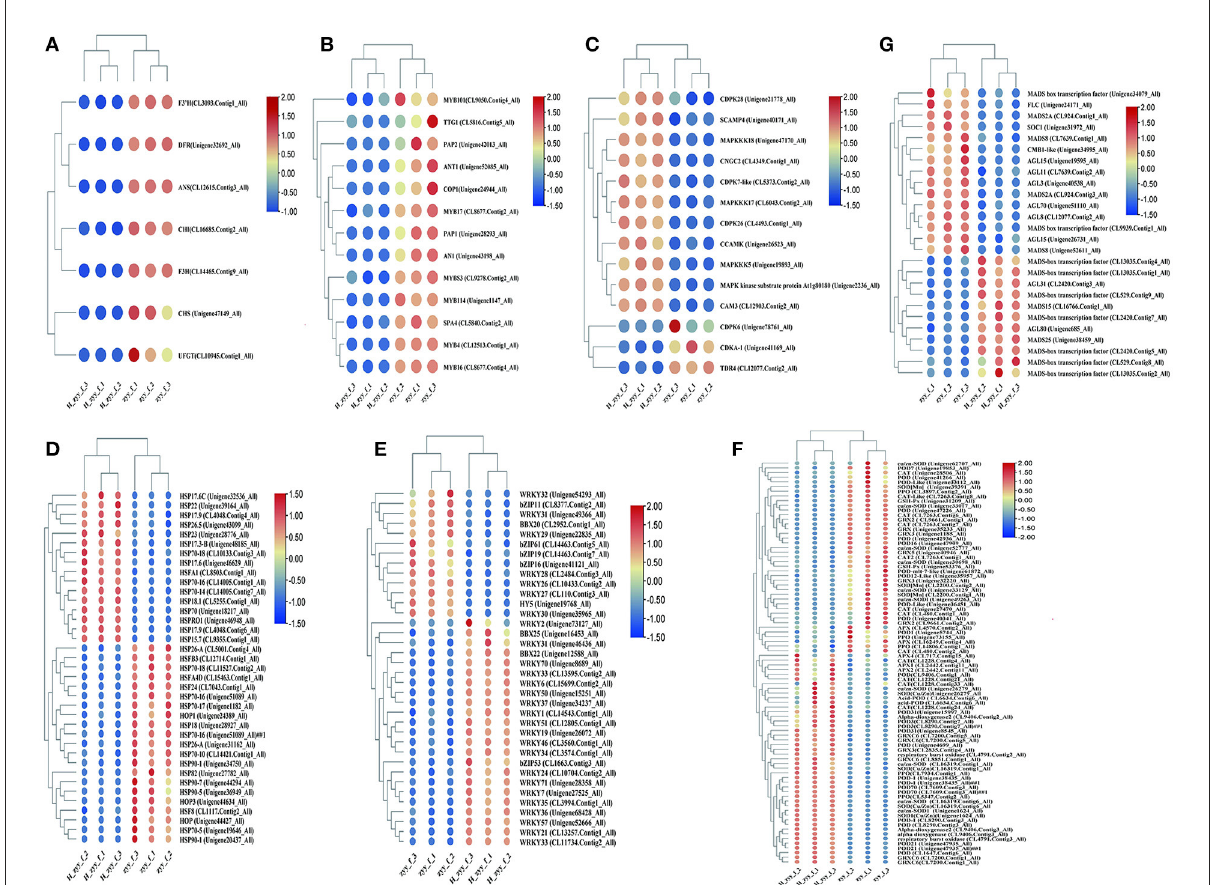
FIGURE6 Mining of major pathways in response to high-temperature stress. (A) Anthocyanin metabolic pathway. (B) MBW transcription factors. (C) Ca 2 + channels and Ca 2 + signaling. (D) HSFs and HSPs. (E) Stress-responsive transcription factors. (F) ROS response pathway. (G) MADS-box transcription